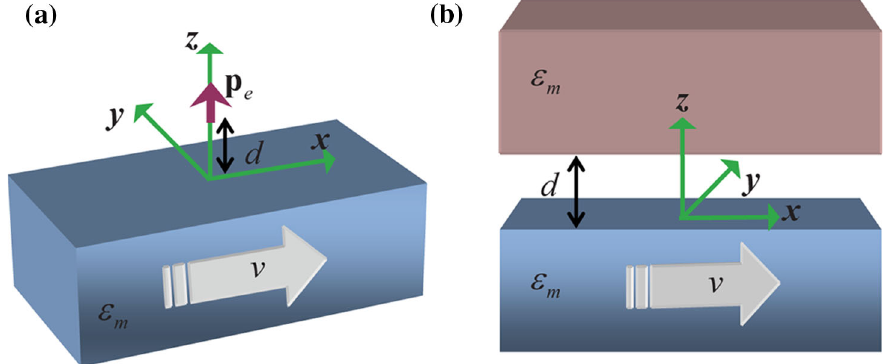
FIG. 1. (a) A vertical electric dipole stands above a semi-infinite metallic region moving with a relative velocity v . (b) Two metallic semi-infinite spaces are separated by a vacuum gap with thickness d . The lower region moves with a relative velocity v